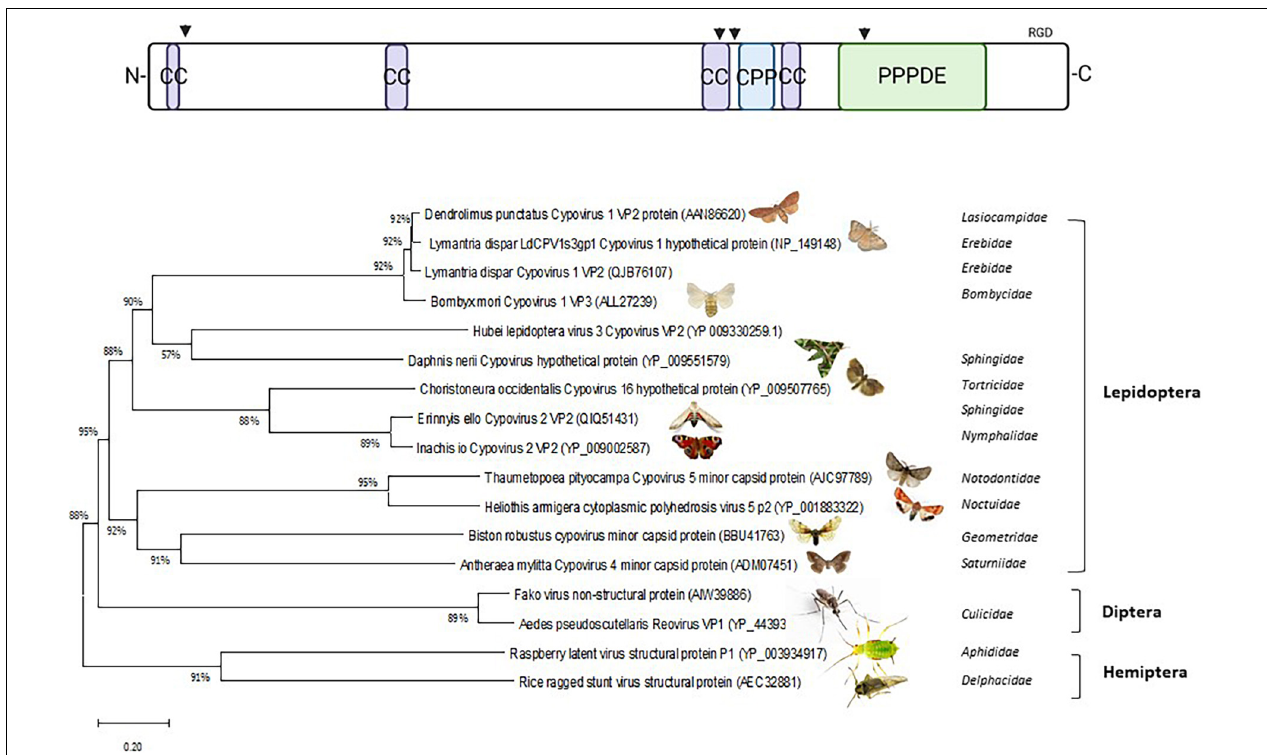
FIGURE 3 | Phylogenetic analysis of VP2/A-spike of Cypovirus. (Top) Schematic of VP2 structure: CC, coiled-coil; CPP, cell-penetration peptide; PPPDE, Permuted Papain fold Peptidases of DsRNA viruses and Eukaryotes. Putative furin and cathepsin proteolytic sites are indicated with arrowheads. RGD is an integrin-interactive motif. Created with BioRender.com. (Bottom) Phylogenetic tree. To search for VP2 of BmCPV1 or Cypovirus 1 (Accession number: ALL27239) homologous proteins in other insect species a protein–protein BLAST search (BLASTp) was performed (https://blast.ncbi.nlm.nih.gov/). The BLAST searches ran against non-redundant protein sequences using the Blosum 62 matrix (Henikoff and Henikoff, 1992). Only the best hits were used with the lowest E -values (one for each organism). Phylogenetic trees and P-Distances were constructed using the neighbor-joining method (Saitou and Nei, 1987) with MEGA5 software (Tamura et al., 2011). Bootstrapping (Felsenstein, 1985) was used to estimate the reliability of phylogenetic reconstructions (1000